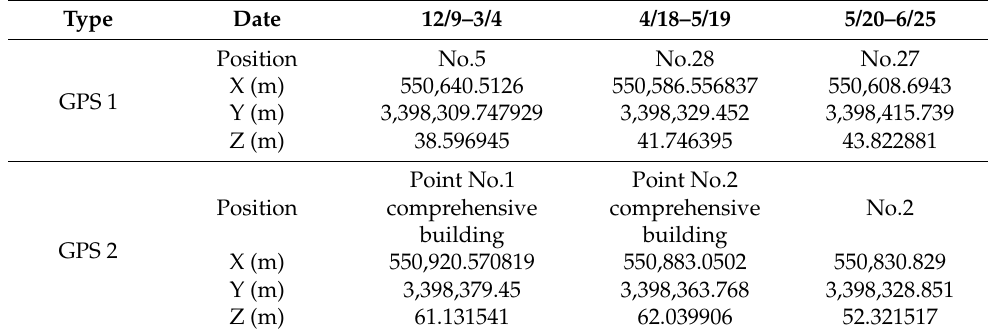
Table 1. GPS solution result